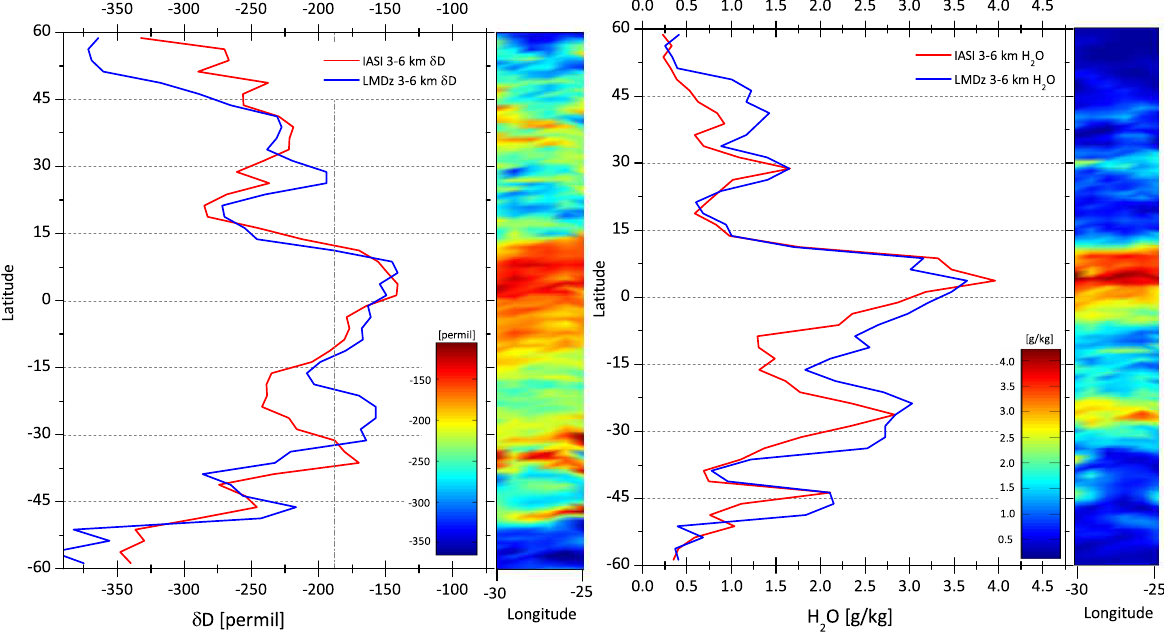
Fig. 11. Latitudinal distribution of δ D (left) with δ D a priori (gray dashed-dotted line) and H 2 O (right) retrieved with IASI (red) and simulated by LMDz-iso (blue). δ D retrievals, representative of the 3–6km layer, have been averaged on the first 15days of January 2010 and on the LMDz-iso grid boxes. The corresponding spatial distributions of IASI retrievals are mapped besides the latitudinal gradients.